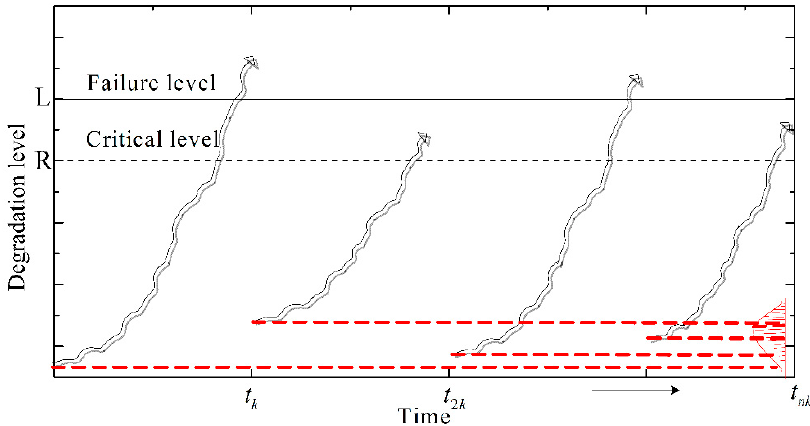
Figure 3. Actual degradation after maintenance.